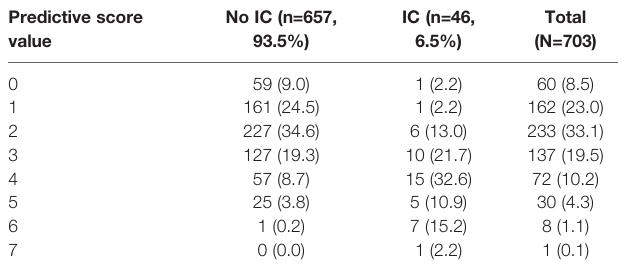
Data are presented as No. (%).